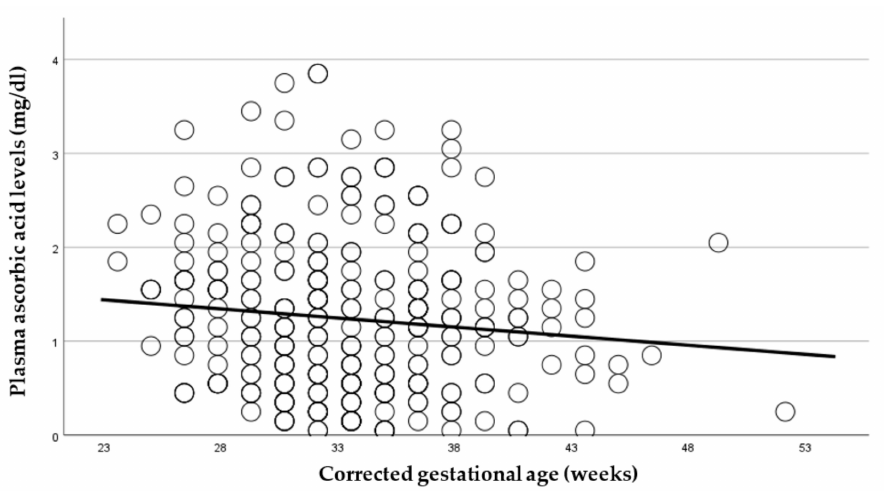
Figure 3. Measured plasma ascorbic-acid levels (mg/dL) in relation to corrected gestational age (weeks). Plasma ascorbic-acid levels were significantly lower with advancing preterm infant maturity outside the maternal womb (corrected gestational age) regardless of gestational age at birth ( p < 0.027).